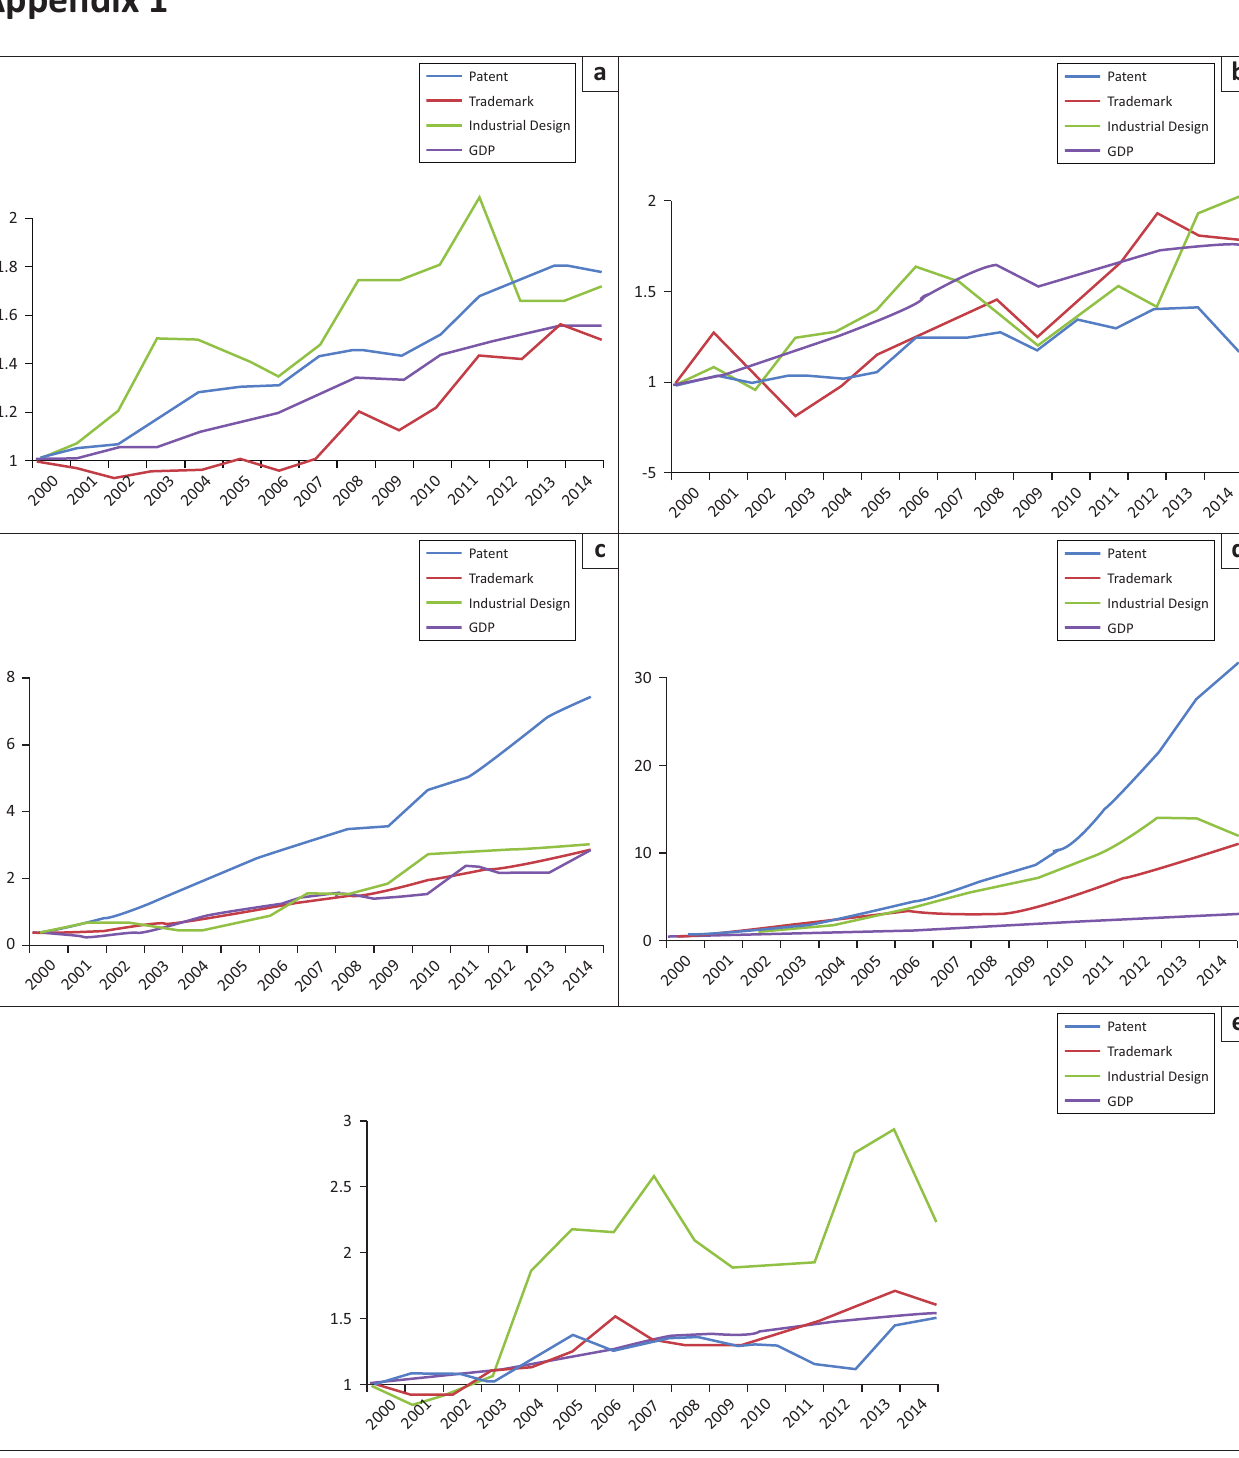
http://www.sajems.org